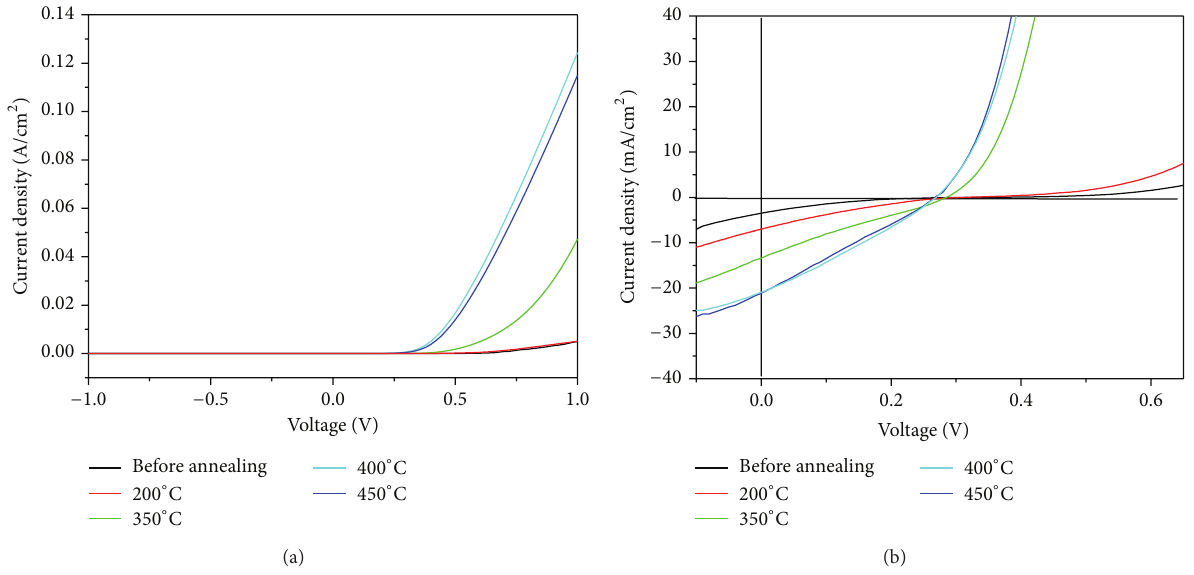
Figure 1: The current density-voltage ( J-V ) curves in dark (a) and under illumination (b) of the Gr-Si solar cell before annealing and after thermal annealing processes at different